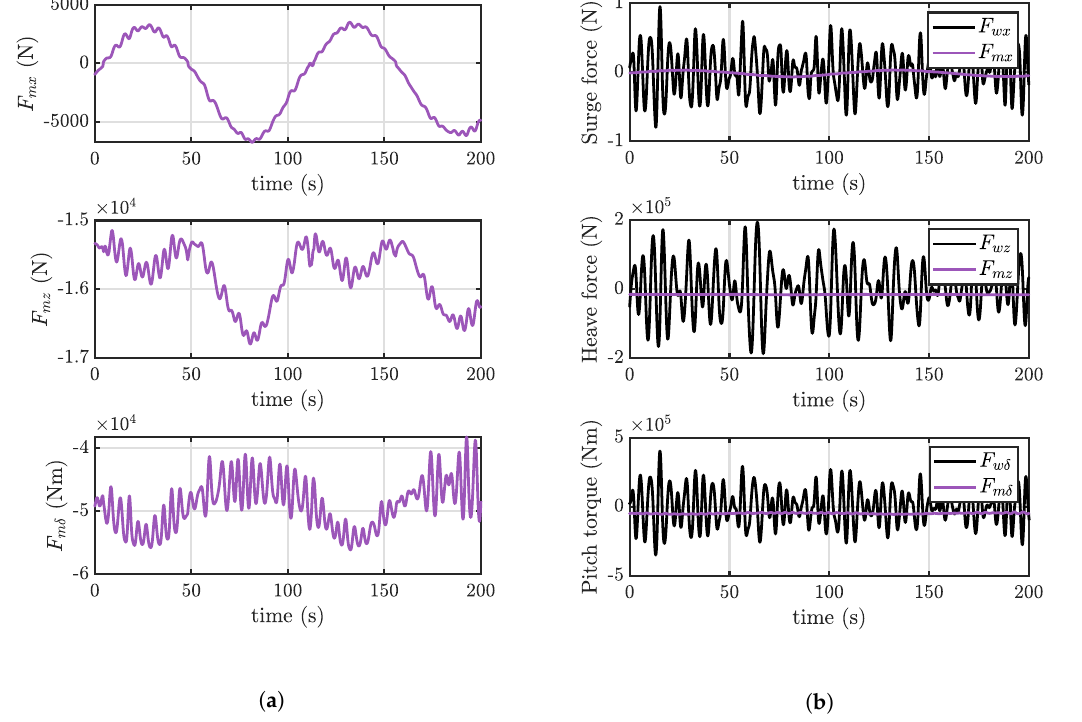
Figure 7. Mooring forces magnitude ( a ) and comparison with WEFs ( b ) (Wave Id 2). ( a ) Mooring forces; ( b ) WEFs and mooring forces